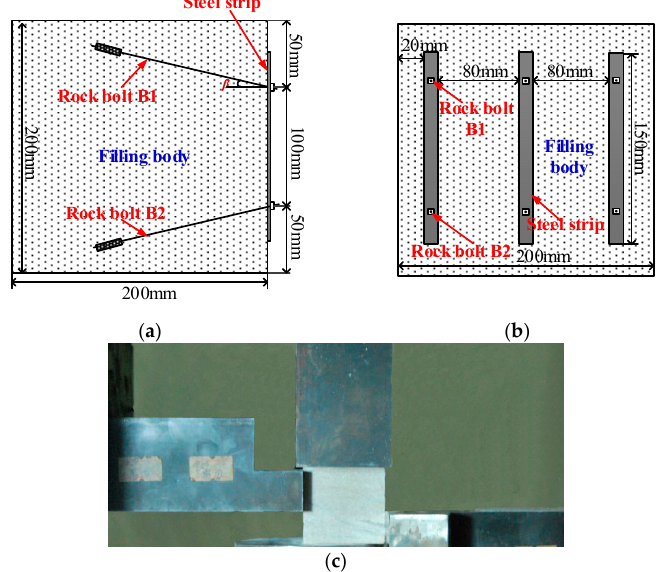
Figure 12. Direct shear test and size of backfill–truss support structure. ( a ) Front view ; ( b ) side view; ( c ) enlargement of local areas . ( c ) enlargement of local